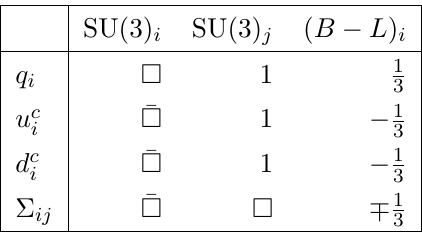
L symmetries (cid:0)